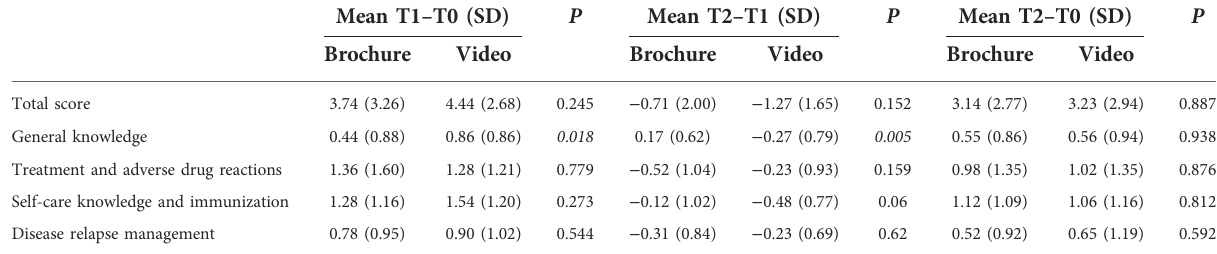
TABLE 3 Mean score differences between immediately post-intervention and before the intervention (T1 – T0), 4 weeks post-intervention and immediately post-intervention (T2 – T1), and 4 weeks post-intervention and before the intervention (T2 – T0).